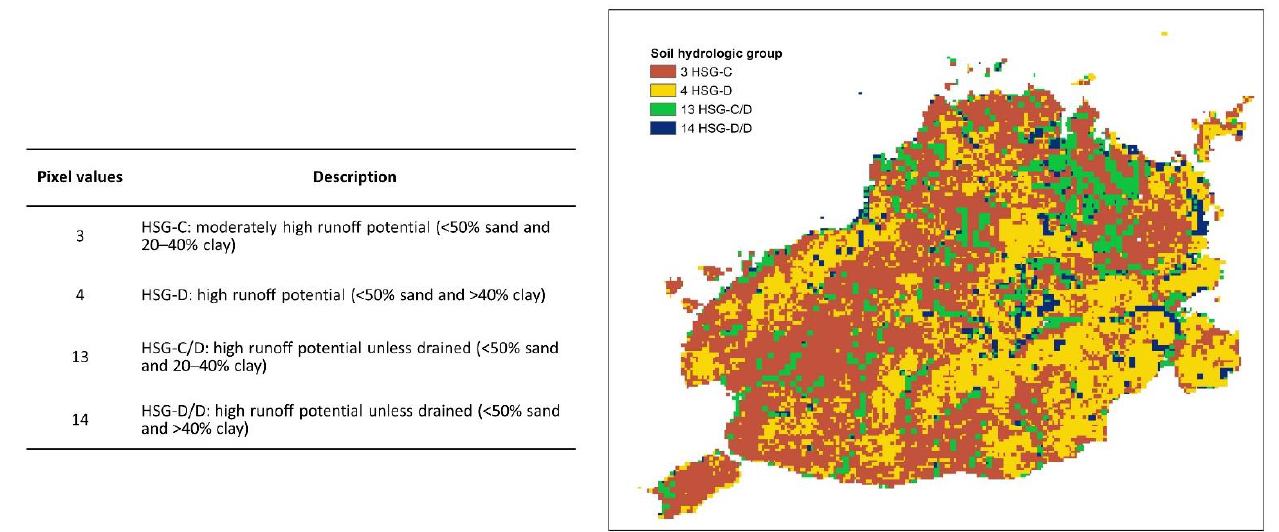
Figure A5. Spatial variation of the hydrologic soil group in the study area.